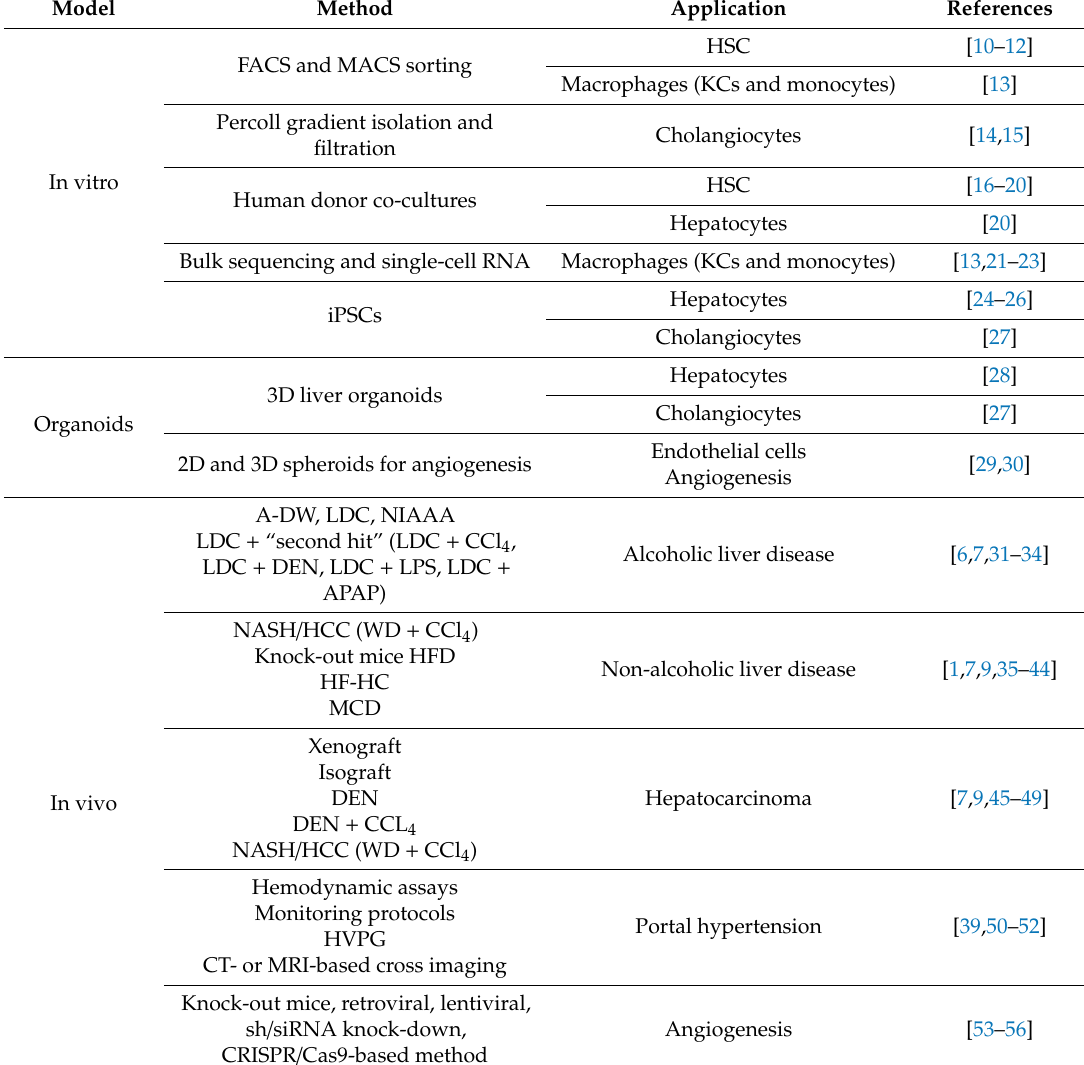
Table 1. Select findings of new methodology applications in in vitro organoids and in vivo